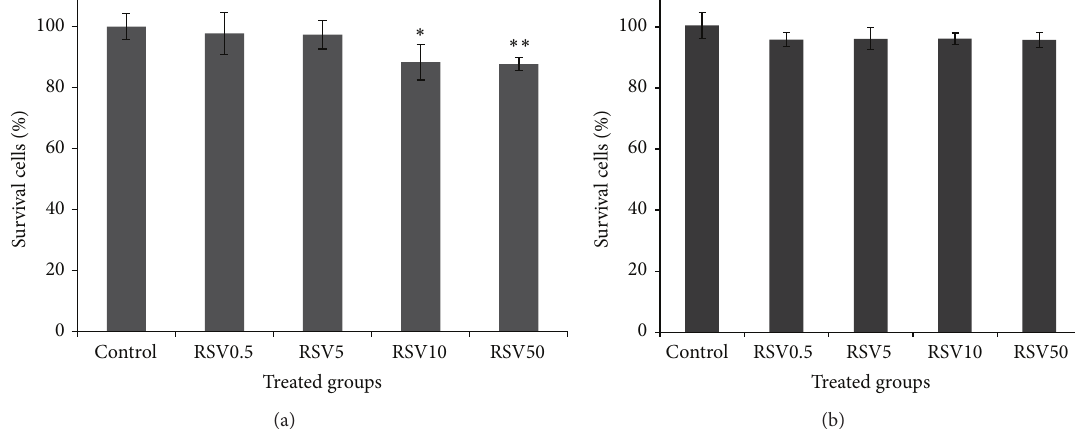
Figure 1: Effect of resveratrol (RSV) at different concentrations (0.5, 5, 10, and 50 𝜇 g/mL) on thyroid cancer cells (a) and nonmalignant fibroblast cell (HFFF2) (b). Cell proliferation was assayed with MTT test ( 𝑛 = 4 ). ∗ 𝑃 < 0.05 , comparing RSV10 with control. ∗∗ 𝑃 < 0.05 , comparing RSV50 with